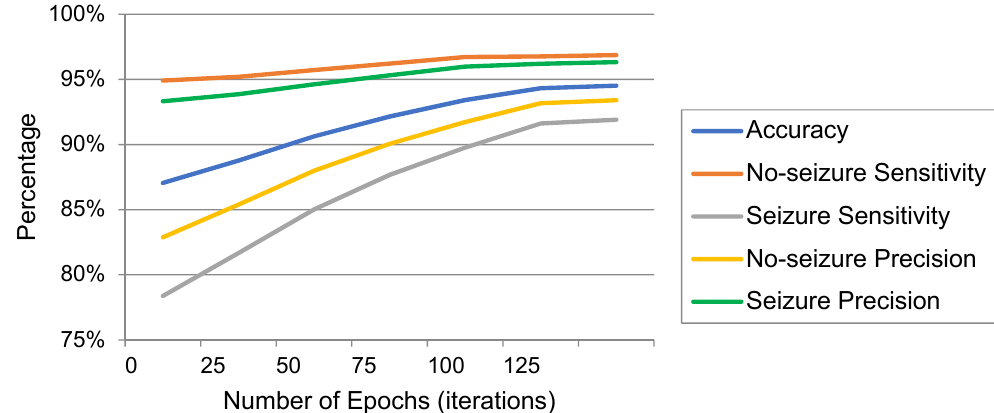
Figure 7. The performance metric charts of testing against the epochs.